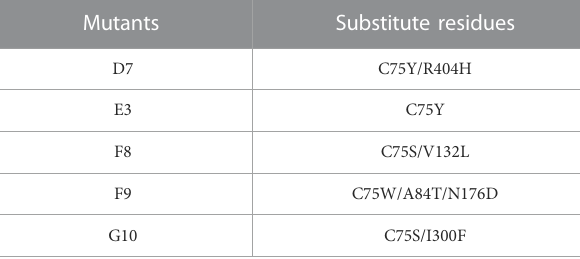
TABLE 1 Substituted residues of mutants.